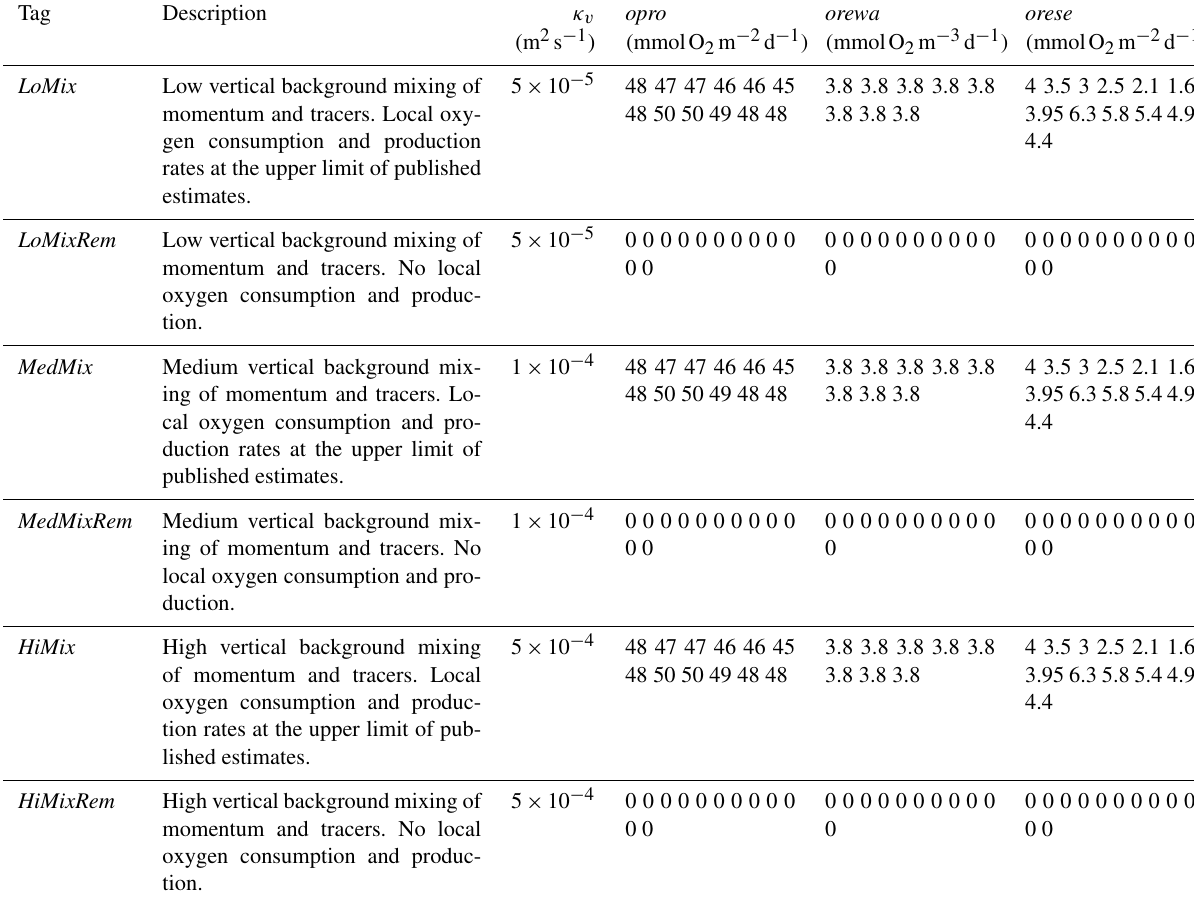
Table 2. List of model parameter settings for the EckO 2 module and diffusive background mixing in MOMBE: κ v refers to vertical back- ground mixing (diffusivity), and opro , orewa , and orese refer to monthly (one value per month starting with the January value) oxygen production, water column oxygen respiration, and oxygen consumption by the sediment, respectively (cf. Fig. 3). Values for orewa and orese are derived from the published estimates listed in Table 1; opro is calculated as residual assuming instant equilibration of sedimentary fluxes.